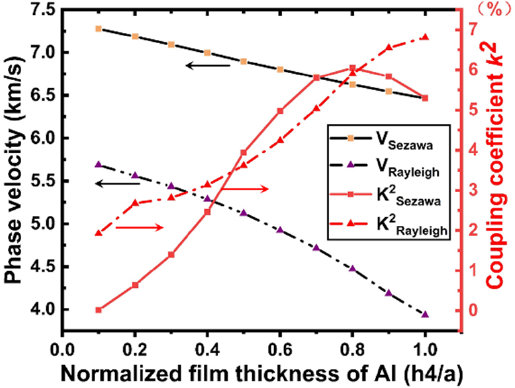
Figure 9. 𝒗 𝒑 and 𝑘 (cid:2870) dependence on ℎ (cid:2872) /𝑎 (when ℎ (cid:2869) /𝑎